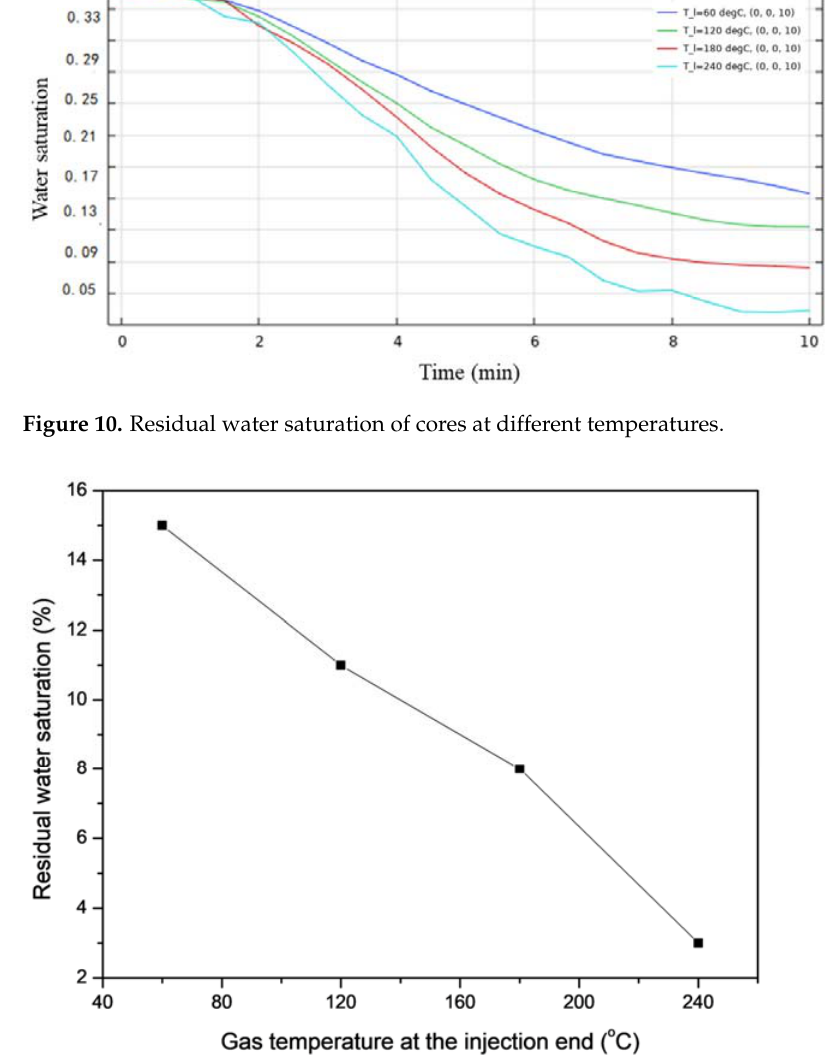
Figure 11. Relationship between residual water saturation with injection gas temperatures.